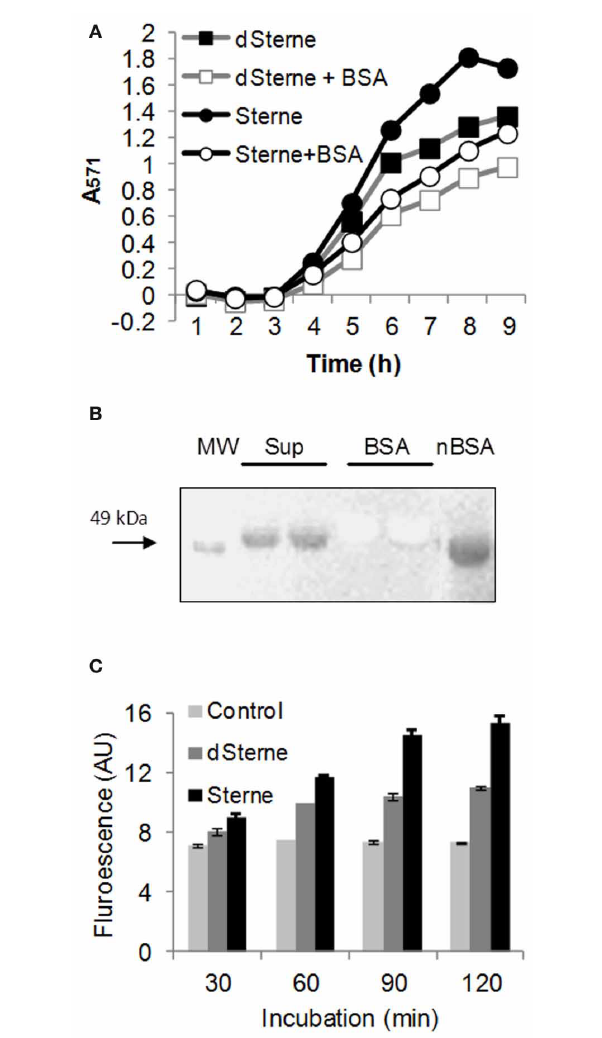
FIGURE 8 | Bacterial growth in microaerobic conditions generates oxidizing species with the properties of PN. (A) BSA inhibits the oxidation of AR catalyzed by HRP in dSterne cultures grown as in Figure 6 in 12-well plates with the addition of 1mg/ml of BSA in DMEM/F12 medium. (B) Western blot of dSterne Sups, unmodified BSA, and nitrated BSA (nBSA) using anti-nitrotyrosine antibodies. Sups were prepared by inoculation of dSterne spores (final concentration of 6 × 10 6 spores/ml) into DMEM/F12 with 1mg/ml of BSA. After 24h, bacteria were removed by centrifugation and gel electrophoresis was performed followed by membrane transfer. Anti-rabbit HRP-linked secondary antibody was used. Sup and BSA lanes are identical duplicates. (C) Fluorescence of DHR indicates the release of peroxynitrite in B. anthracis cultures. Bacteria grown statically for 18h in complete DMEM/F12 medium were pelleted, washed with PBS, resuspended in PBS containing DHR, and incubated at 37 ◦ C, 5% CO 2 for the indicate periods of time for detection of fluorescence at 500/540nm. Error bars indicate 95% confidence intervals.